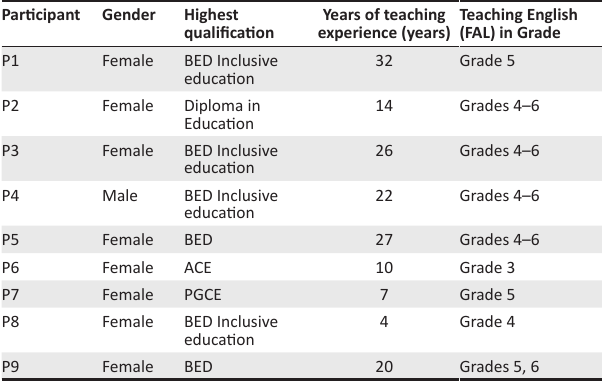
TABLE 1: Biographical details of participants in the semi-structured individual interviews.